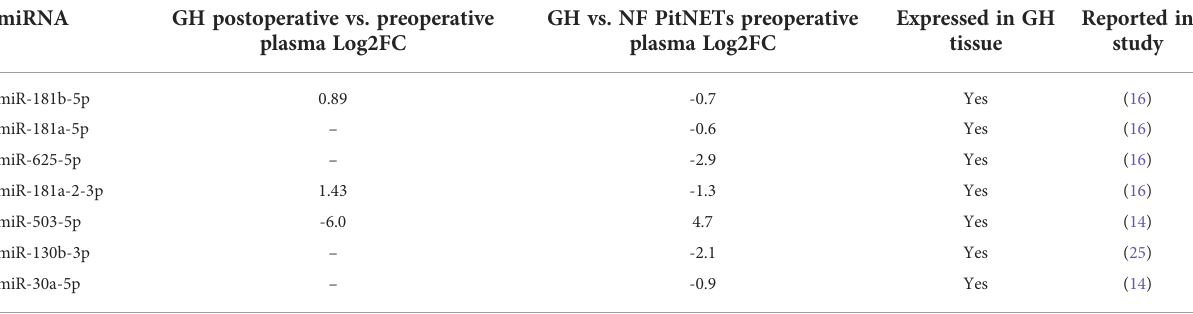
TABLE 4 Selection candidate miRNAs for further evaluation by qPCR. miRNA GH postoperative vs. preoperative GH vs. NF PitNETs preoperative plasma Log2FC plasma